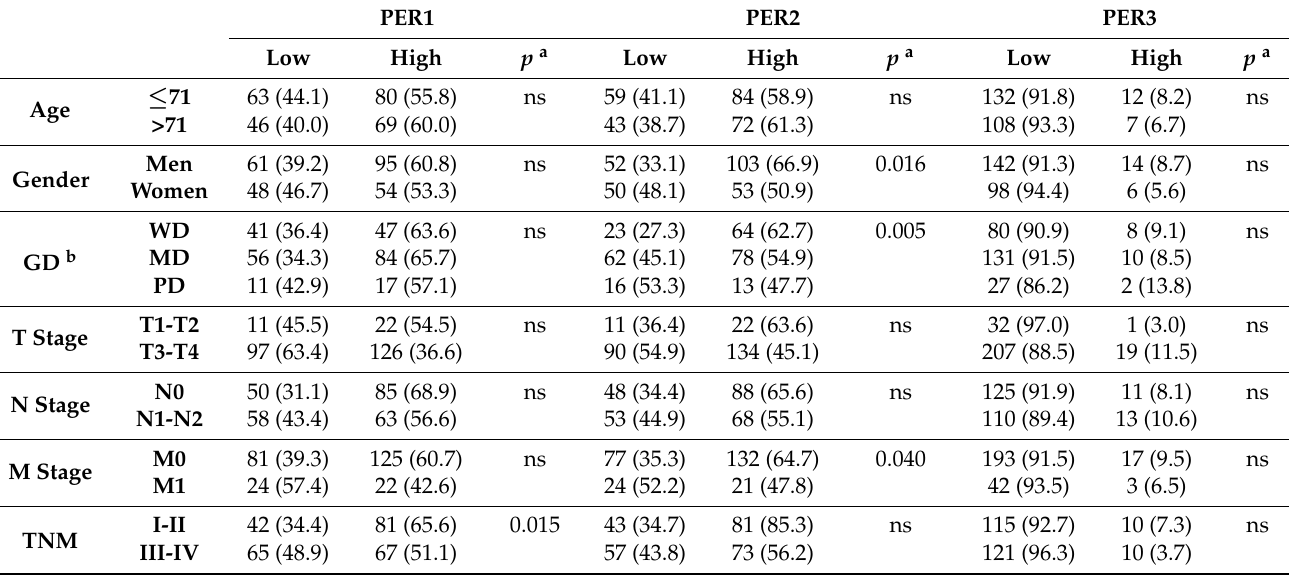
Table 4. Relationship between expression levels of circadian proteins and clinicopathologic features of the individuals included in the study.